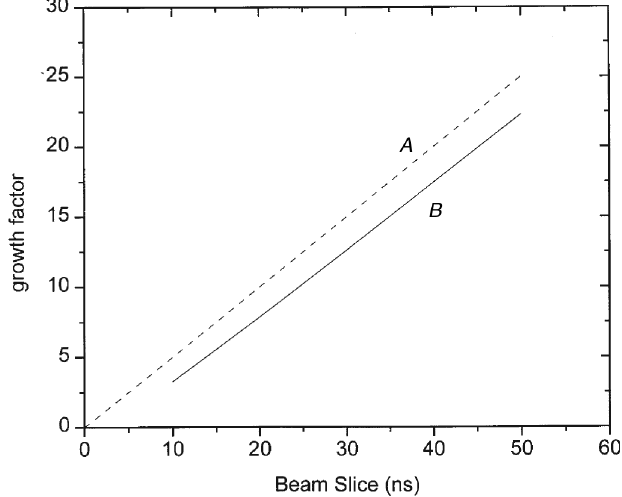
FIG. 1. For a Bennett conductivity profile, comparison of ( A ) upper bound for growth factor from dispersion analysis and ( B ) observed growth factor from numerical integration of model equations.